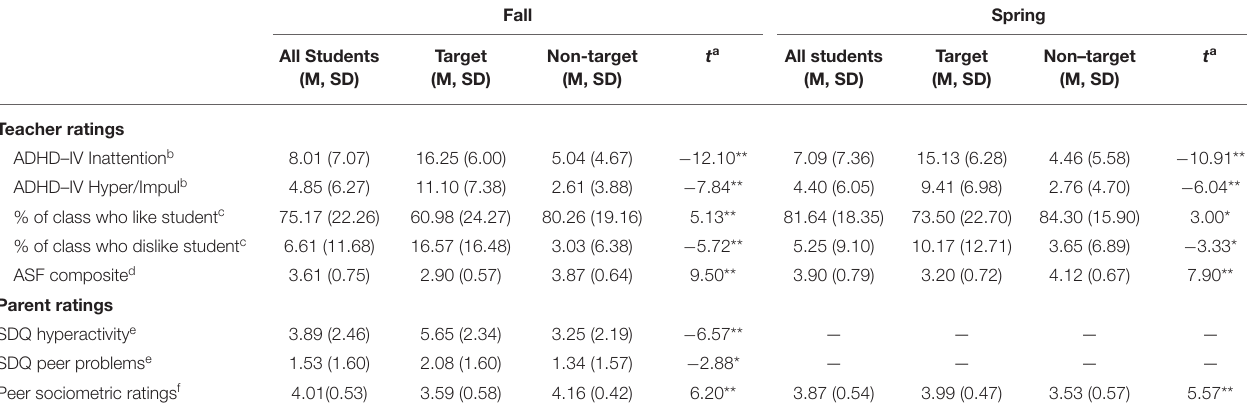
TABLE 2 | Descriptive statistics on study measures for target and non-target students.